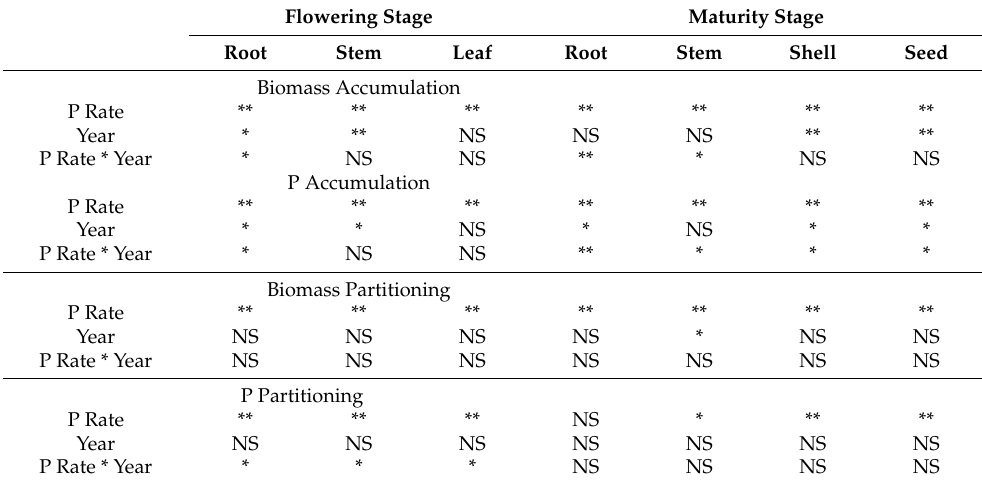
Table 3. The ANOVA results of effects of P rate on biomass, P accumulation, and partitioning in a saline